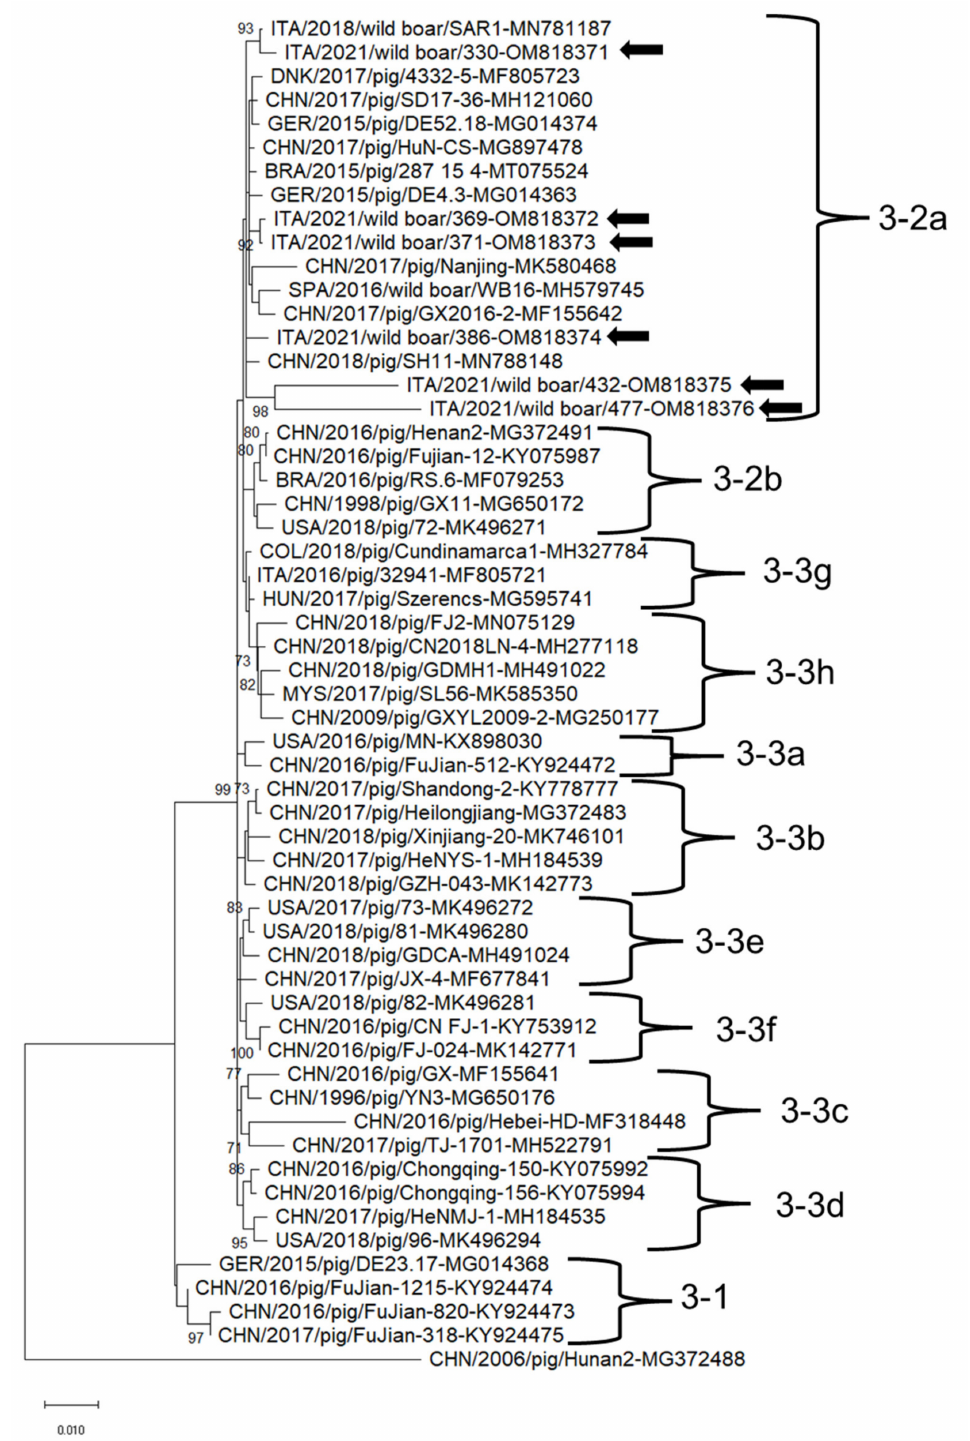
Figure 3. Full-genome-based unrooted phylogenetic tree Porcine circovirus 3 strains identified in this study and reference strains recovered in the GenBank database. The Maximum Likelihood method and Tamura-Nei model (four parameters) with a gamma distribution and invariable sites were used for the phylogeny. A total of 1000 bootstrap replicates were used to estimate the robustness of the individual nodes on the phylogenetic tree. Bootstrap values greater than 70% were indicated. Black arrows indicate strains detected in this study. Numbers of nucleotide substitutions are indicated by the scale